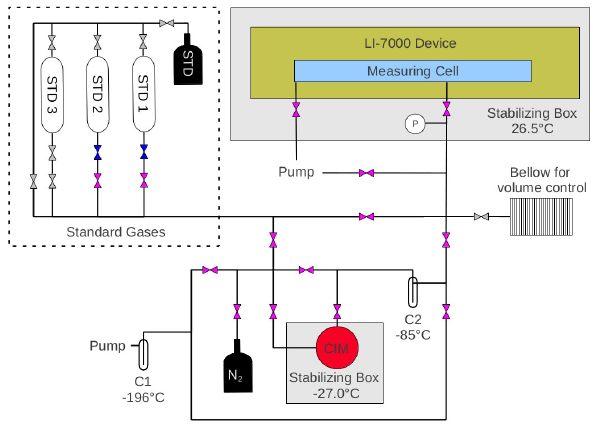
Fig. 2. Schematic illustration of the complete system for CO 2 mea- surements on polar ice cores. Red circle: CIM (details in Fig. 1); green rectangle: LI-7000 optical CO 2 analyser from LI-COR with its measurement cell (blue); hashed rectangle: adjustable volume using a membrane bellow (stainless steel); dashed rectangle: stan- dard gas unit with three standard gas reservoirs (STD 1-3); grey squares: temperature stabilizing boxes used for the LI-7000 and the CIM; C1 and C2: cold traps; P : pressure gauge; pink valves: pneu- matically actuated diaphragm valves; blue valves: pneumatically actuated full-metal bellow valves; grey valves: manually actuated full-metal bellow valves. The ends of the vacuum line marked with a pump are connected to vacuum pumps. All vacuum valves and fittings are made of stainless steel and manufactured by